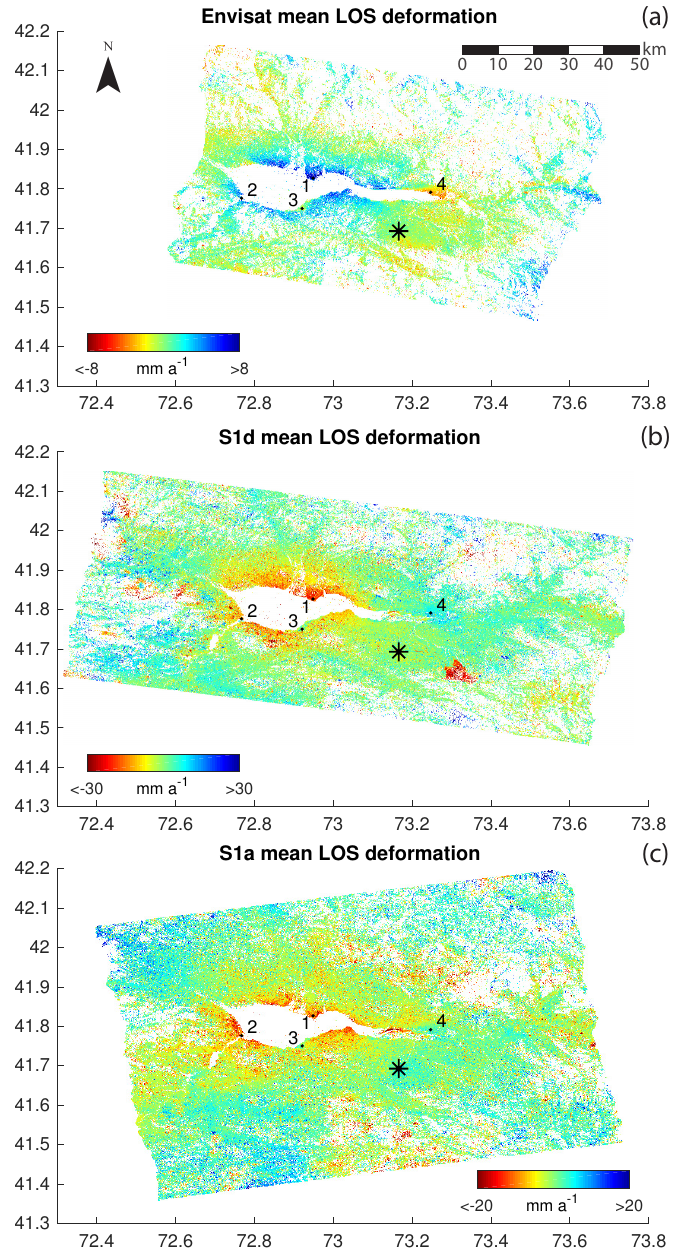
Figure 6. Power-law-corrected mean LOS deformation maps for ( a ) Envisat; ( b ) S1d and ( c ) S1a SAR time series. Points 1-4 show the locations of the deformation time series shown in Figure7, and the black asterisk denotes the reference point used in the time series. The red triangle area in the southeast corner of the S1d time series shows an unwrapping artifact that we did not correct